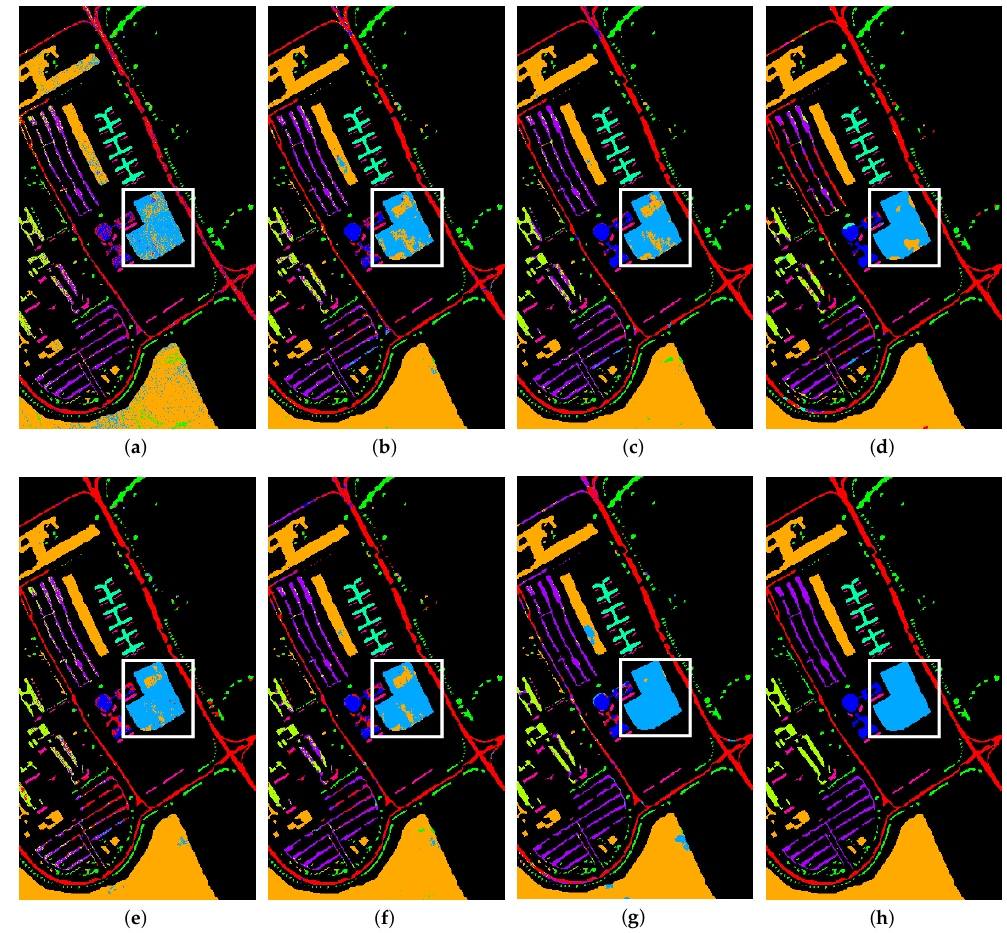
Figure 7. Classification maps for PU dataset. ( a ) SVM; ( b ) 2D-CNN; ( c ) 3D-CNN; ( d ) HybridSN; ( e ) PMI-CNN; ( f ) MSCNN; ( g ) Proposed method ( h ) Reference